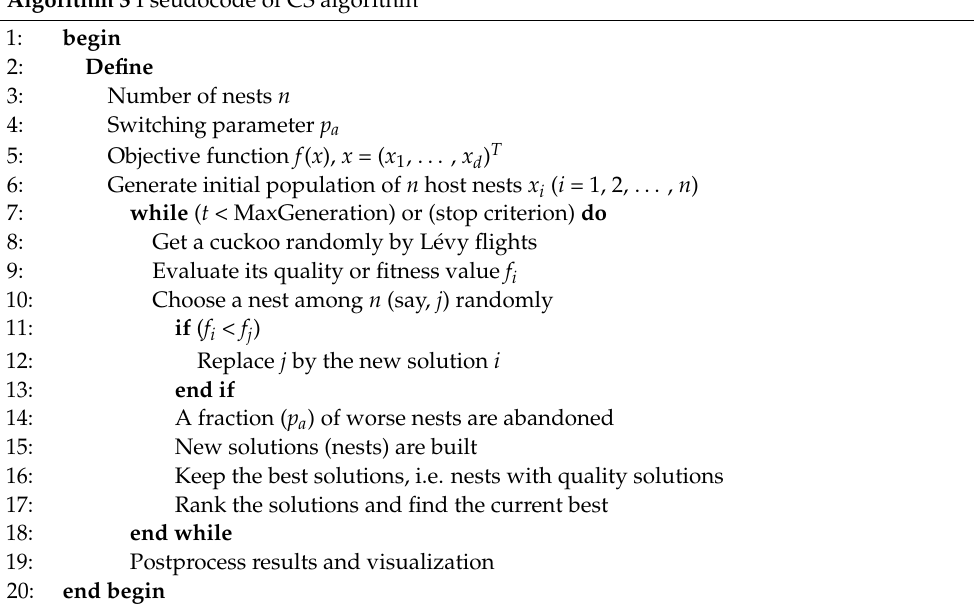
Algorithm 3 Pseudocode of CS algorithm